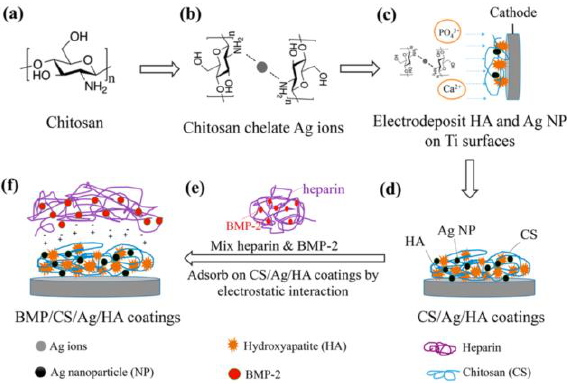
Figure 12. Schematic diagram of the different steps for the electrochemical deposition and immobilization of (bone morphogenetic protein -2 (BMP-2) on hydroxyapatite (HA) coatings (adapted with permission from reference [63]).